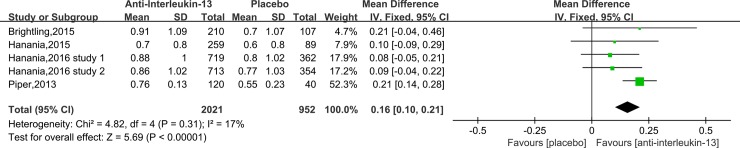
Forest plot comparing anti-IL-13 and placebo with AQLQ scores.